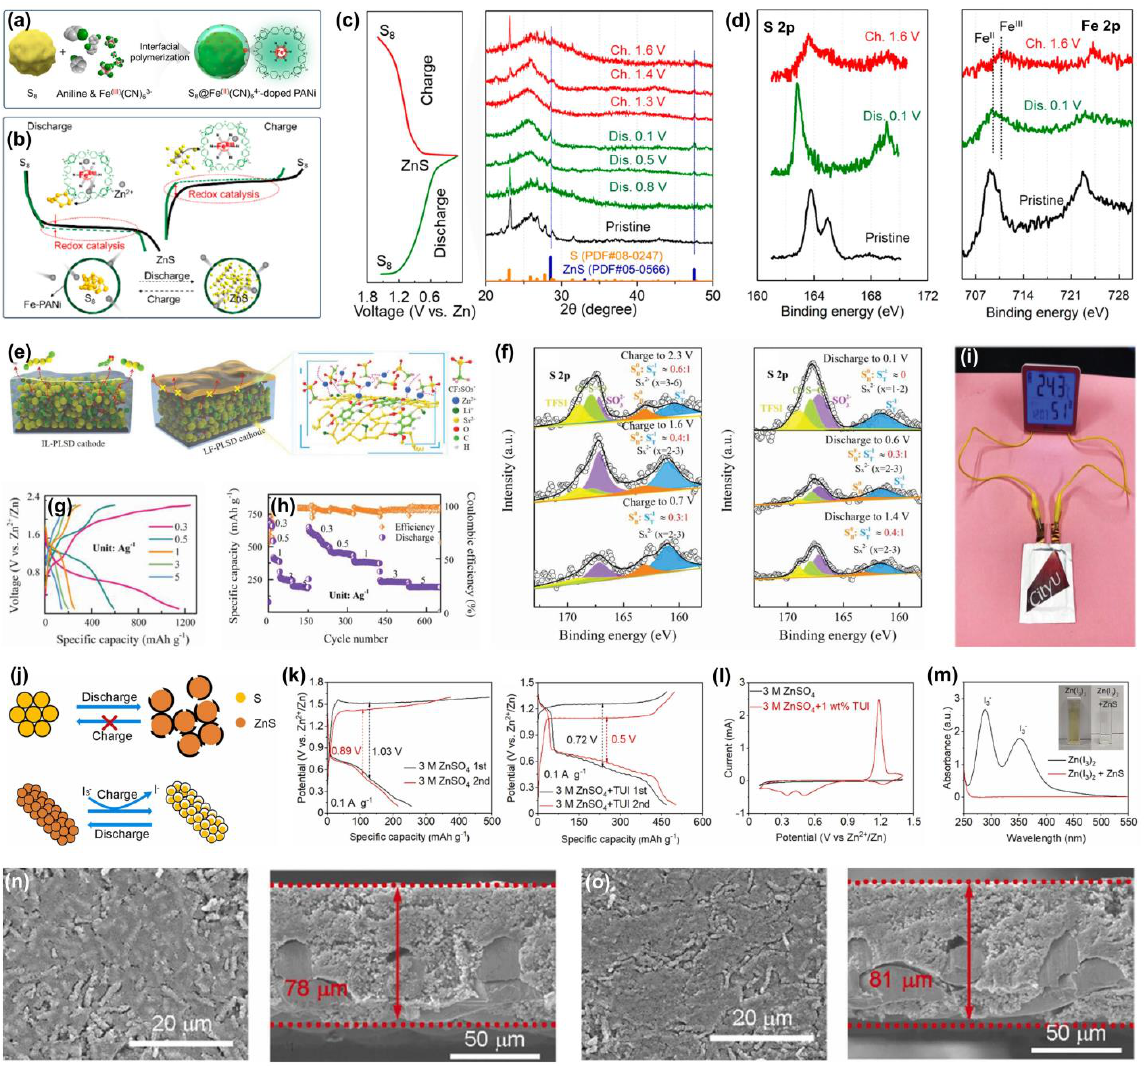
Figure 8. ( a ) Schematic of the synthesis process for S@Fe-PANi; ( b ) schematic of S redox